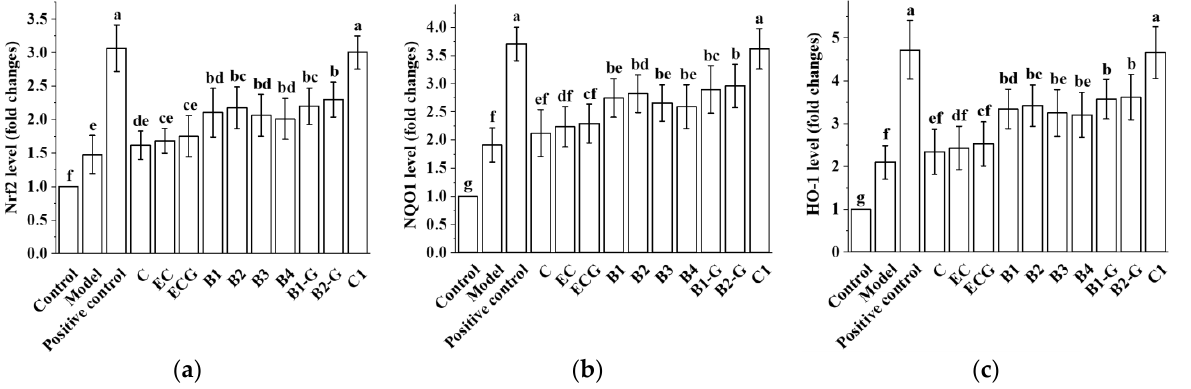
Figure 10. Effects of different structural procyanidins on the Nrf2/ARE pathway in the zebrafish PD model. ( a ) Nrf2 levels. ( b ) NQO1 levels. ( c ) HO-1 levels. Control, Blank control group; Model, MPTP (400 µM); Positive control, Deprenyl (40 µM) + MPTP (400 µM); C: C (25 µM) + MPTP (400 µM); EC: